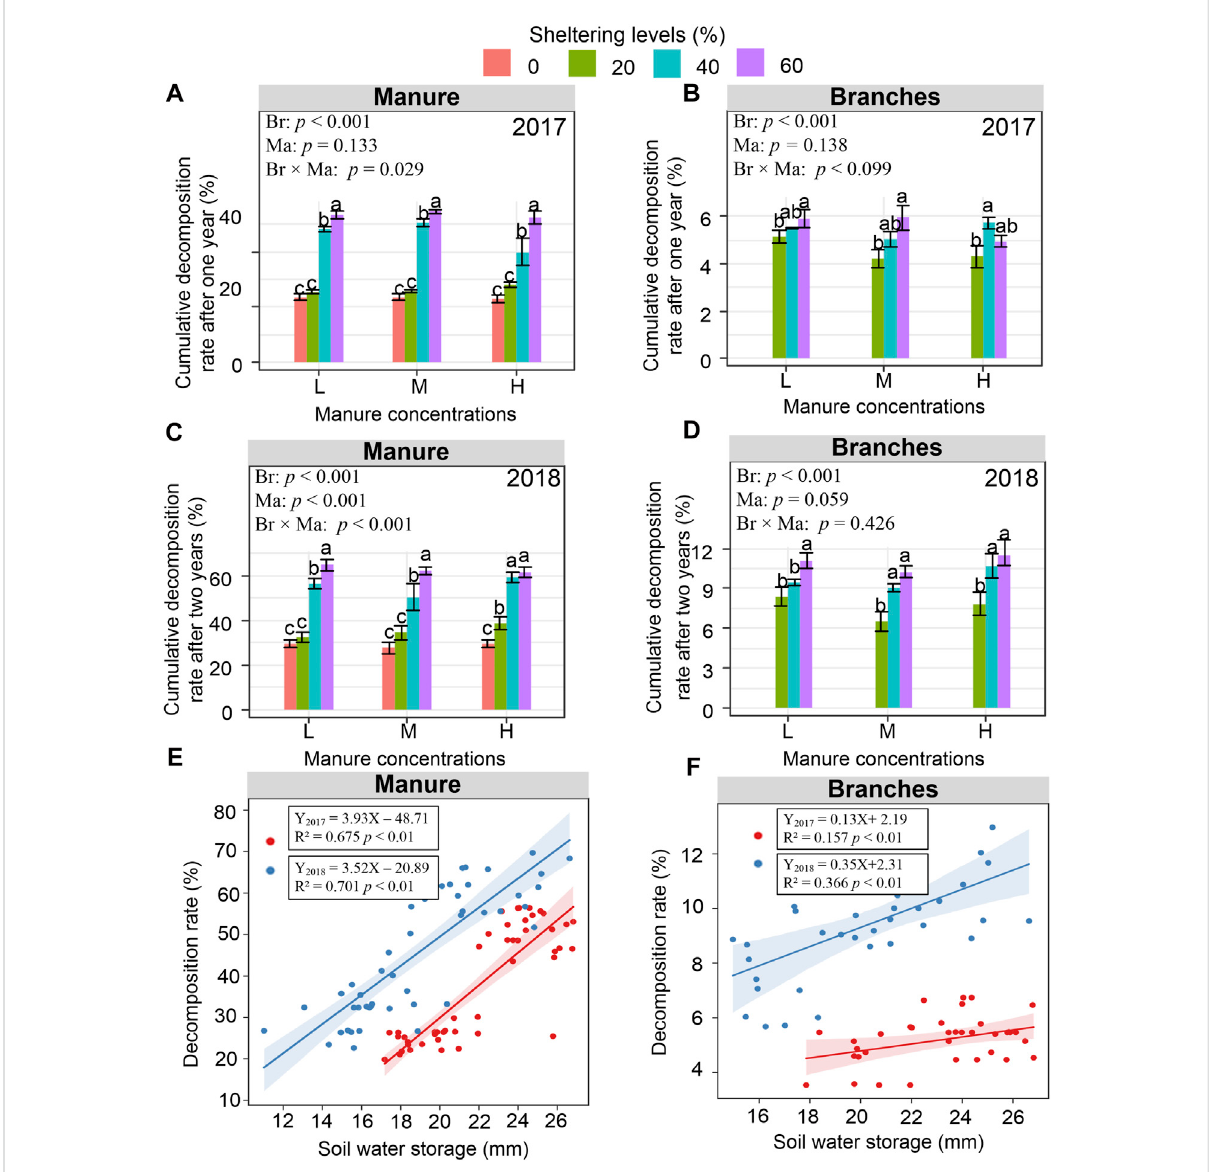
FIGURE 3 Decompositionratesofmanure (A,C) andcaraganabranches (B,D) underdifferenttreatmentsevaluatedas%weightlossfromtheinitialweight, as well as regressions ofdecomposition rate againstsoil water storage (mm) for manure treatments (E) and caraganatreatment (F) in 2017 and 2018. Different letters above columns in Figs a, b, c, and d indicate signi fi cant differences among different sheltering levels in Figs a and b ( p < 0.05). Different p values in Figs a, b, c, and d show the effects of branch sheltering (Br), manure concentration (Ma), and their interaction (Br × Ma) on decomposition by two-way